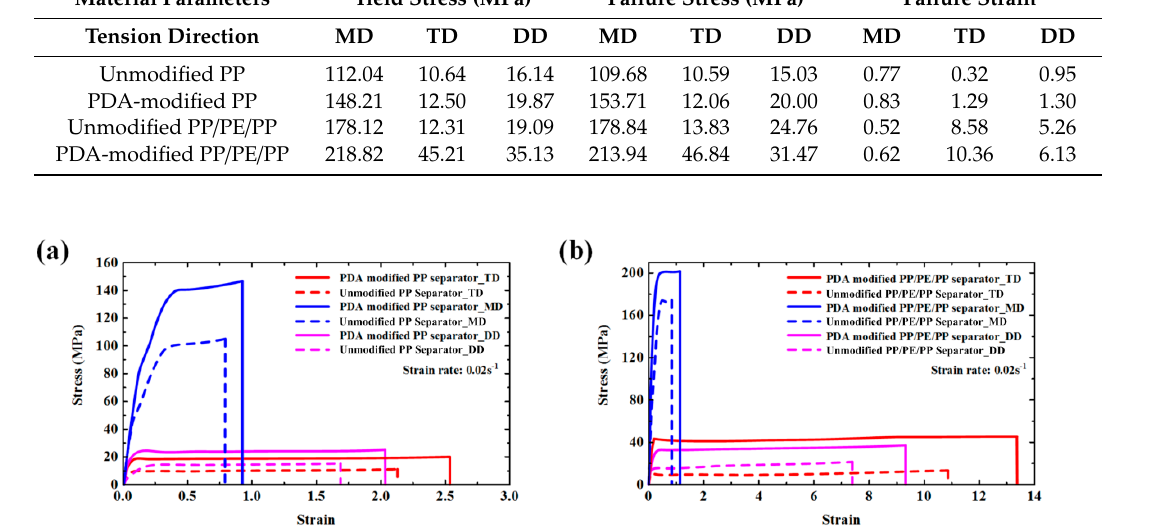
Table 3. Material parameters of unmodified and PDA-modified separators along TD, MD, and DD under strain rates 0.02 s − 1 .